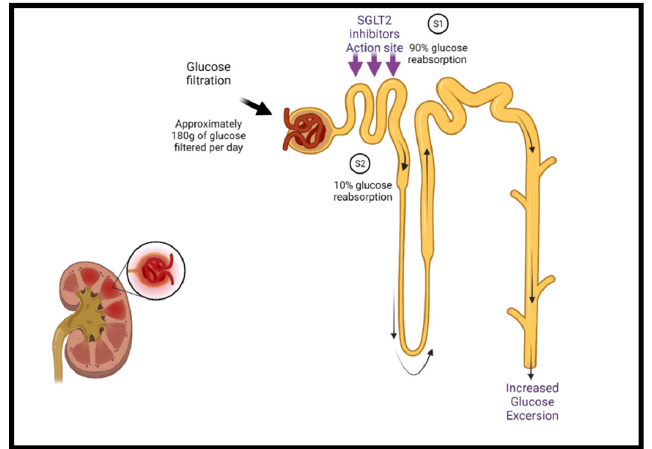
Figure 1. The mechanism of SGLT2 class inhibitors. Under normal conditions, glucose filtration at the nephron reabsorbs glucose back into the bloodstream, approximating 180 g per day. Sodium– glucose cotransporters are present in the proximal convoluted tubule of the nephron (S1 segment) containing SGLT2 and at the distal end (S2 segment) containing SGLT1. SGLT2 is responsible for the reabsorption of 90% of the sodium/glucose, whereas SGLT1 is responsible for the remaining 10%. SGLT2 inhibitors act on SGLT2 proteins at the S1 position and reduce sodium/glucose reabsorption, leading to increased urinary excretion of sodium and glucose, finally lowering blood glucose lev- els. Additional cardiac-specific mechanisms have been proposed and are currently being studied. SGLT2 = sodium–glucose